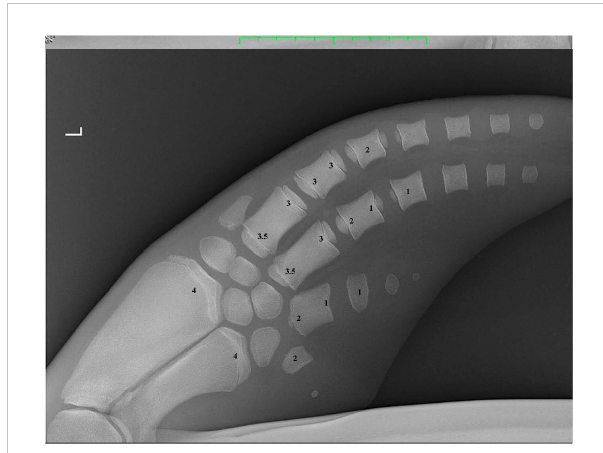
FIGURE 3 A pectoral fl ipper radiograph demonstrating the open physeal plates present in a young sexually immature dolphin. The scores for each of the 16 locations are provided on the radiograph. L, Left pectoral fl